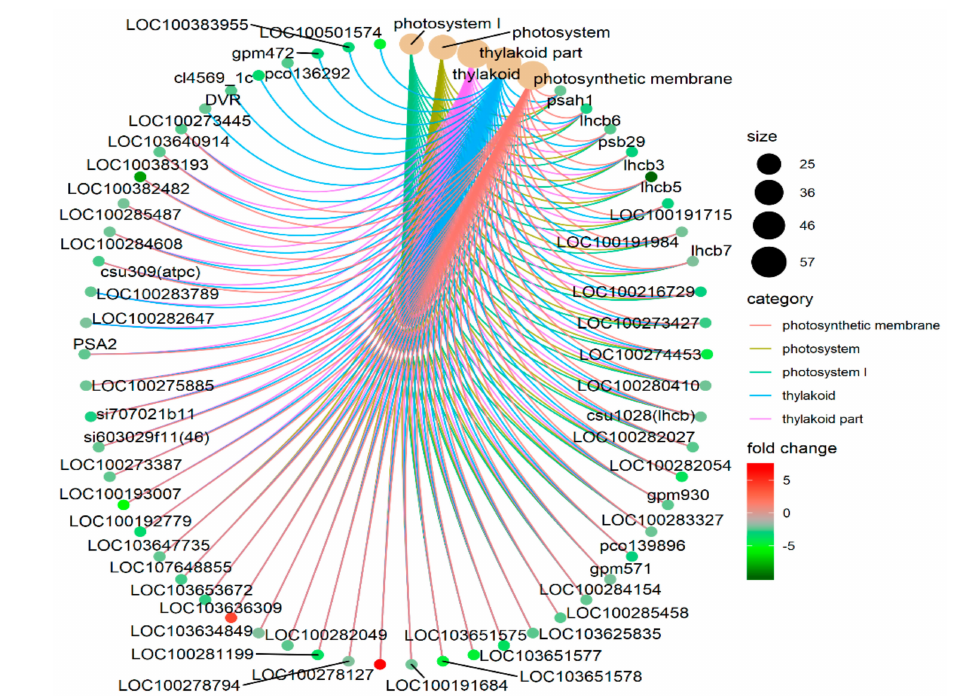
Figure 6. Di ff erent cellular components connect